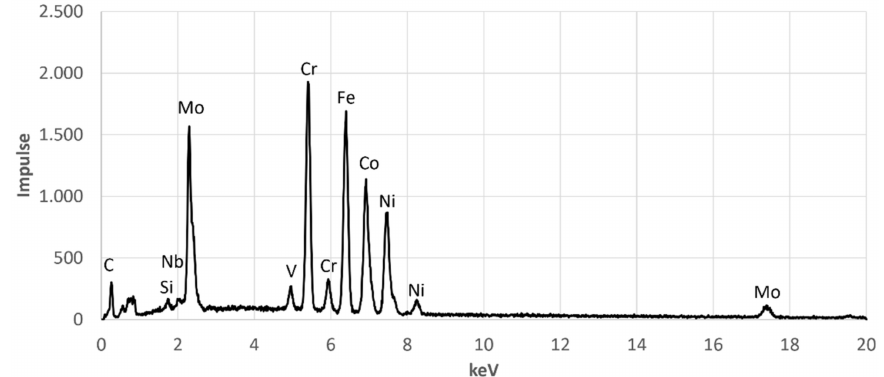
Figure A3. EDX-Spectrum for EDX Point